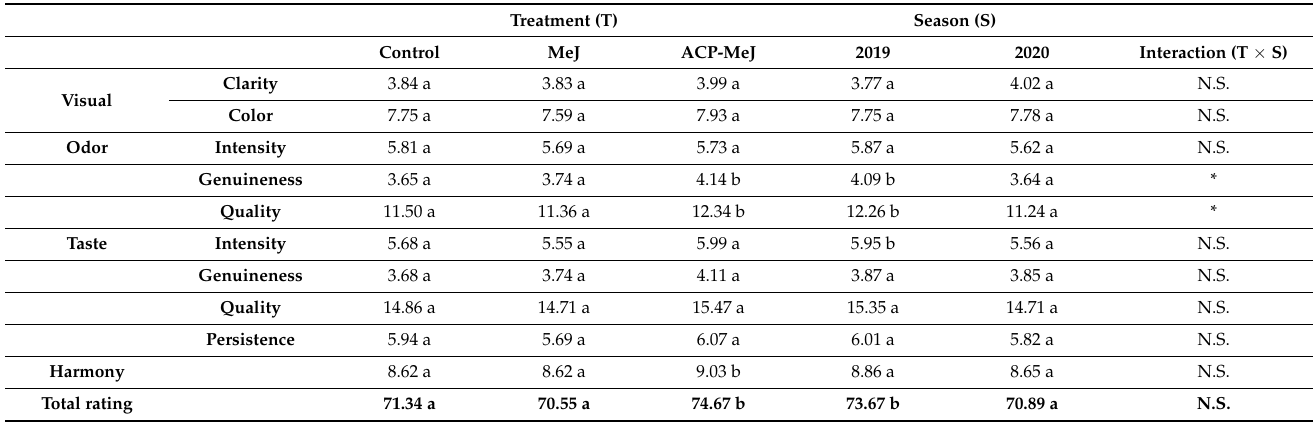
Table 5. Factor analysis of the sensory evaluation of the wines with the two factors studied: treatment (Control, MeJ, ACP-MeJ) and season (2019 and 2020).